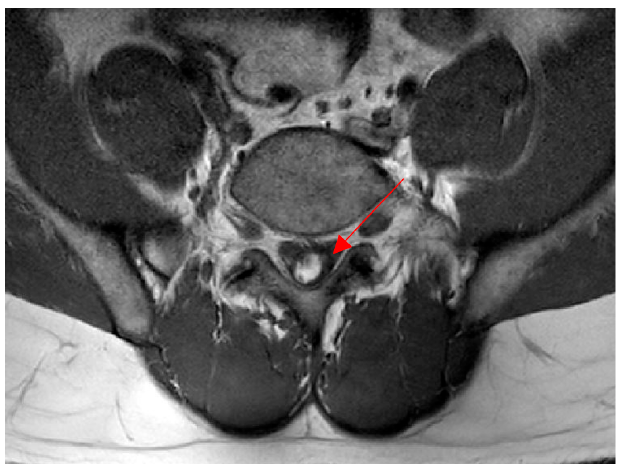
Figure 3. Hematoma (arrow) on the intradural side on magnetic resonance imaging (T2). In the horizontal section, the hematoma was observed on the spinal intradural side.